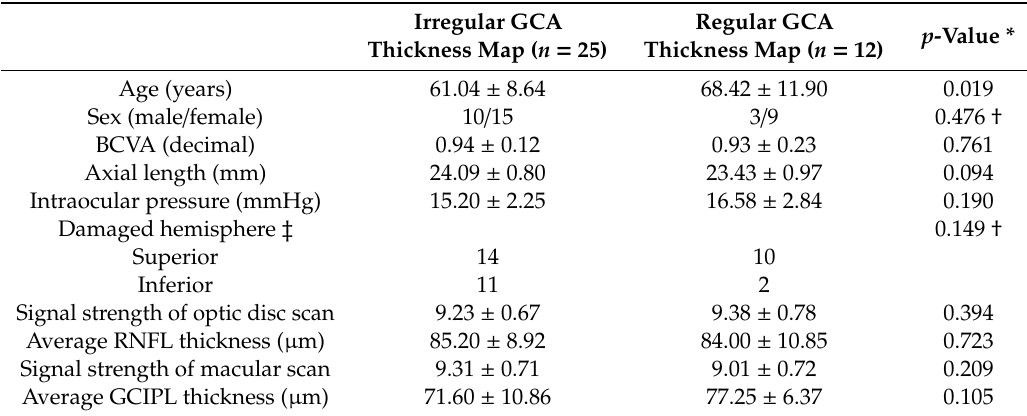
Table 4. Demographics of patients with retinal vein occlusion.